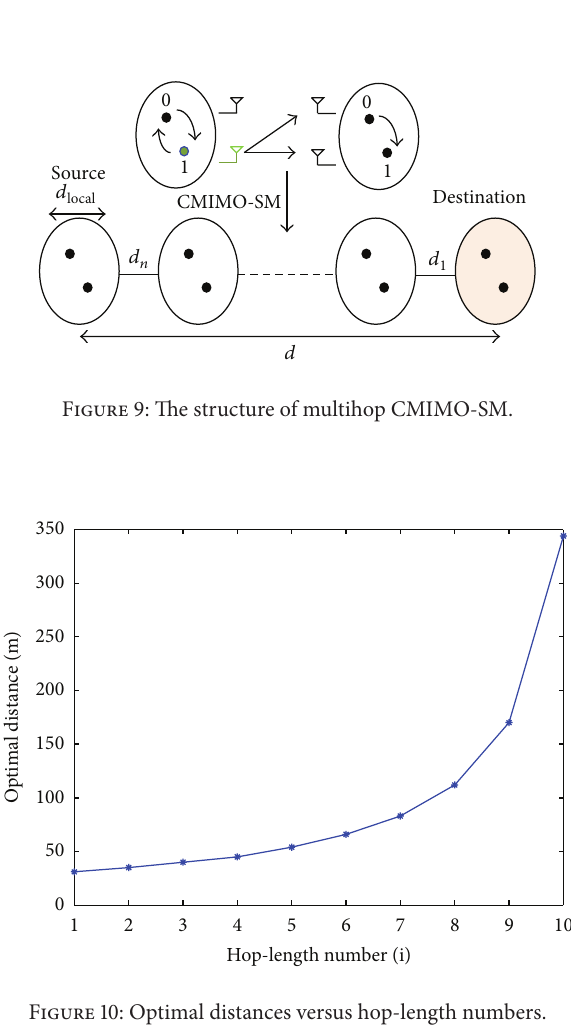
Figure 8: Total energy consumption per bit over d , 4bits transmis- sion.